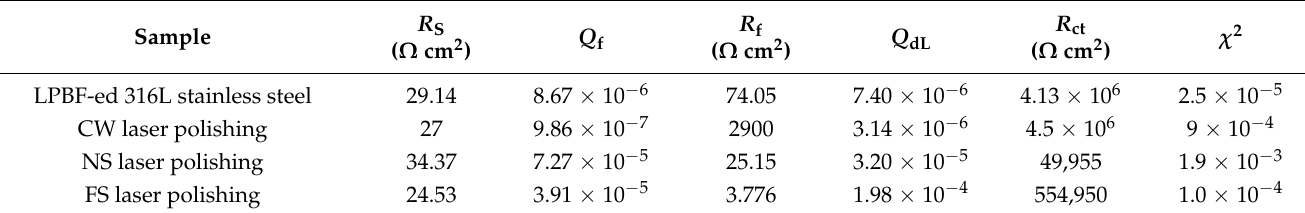
Table 5. EIS fitting results of an equivalent circuit model for original and laser-polished